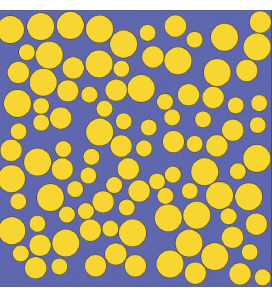
Figure 17: The generated random model with nonuniform fiber size for the case of 100 fibers and v f =